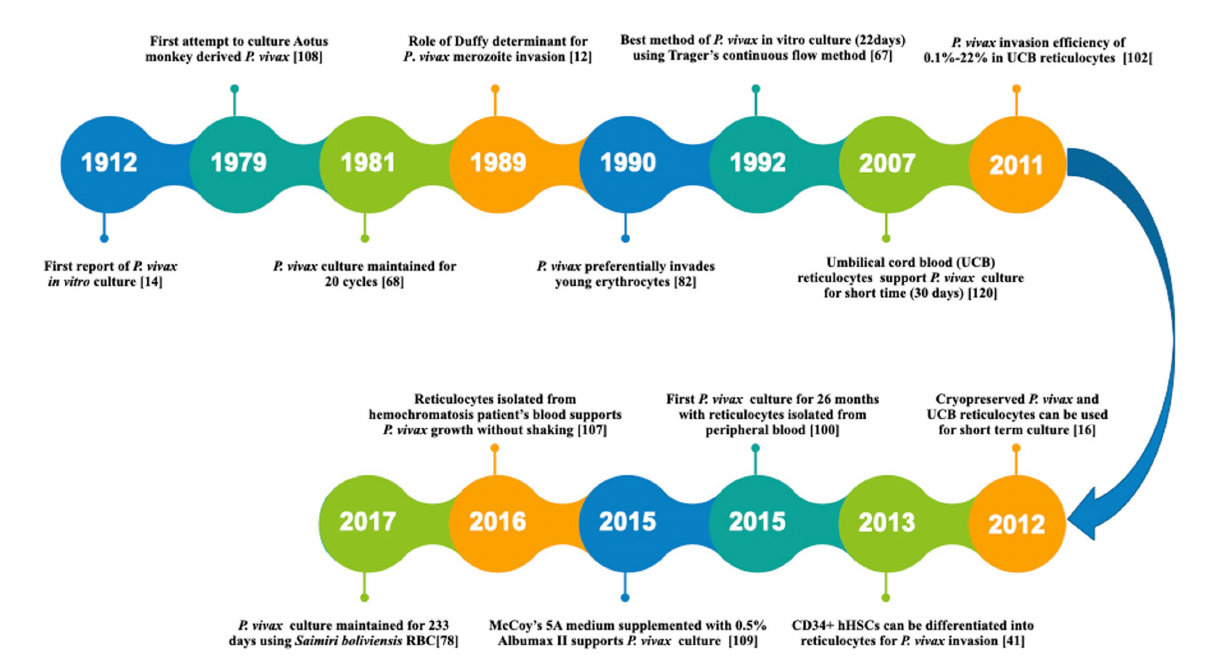
FIGURE 2 A timeline representing the major developments towards P. vivax in vitro culture. [14]: Bass and Jones (1912) [108]: Siddiqui (1979) [68]: Larrouy et al. (1981) [12]: Barnwell et al. (1989) [82]: Mons (1990) [67]: Lanners (1992) [120]: Udomsangpetch et al. (2007) [102]: Russell et al. (2011) [16]: Borlon et al. (2012) [41]: Fernandez-Becerra et al. (2013) [100]: Roobsoong et al. (2015) [109]: Singh et al. (2015) [107]: Shaw-Saliba et al. (2016) [78]: Mehlotra et al.